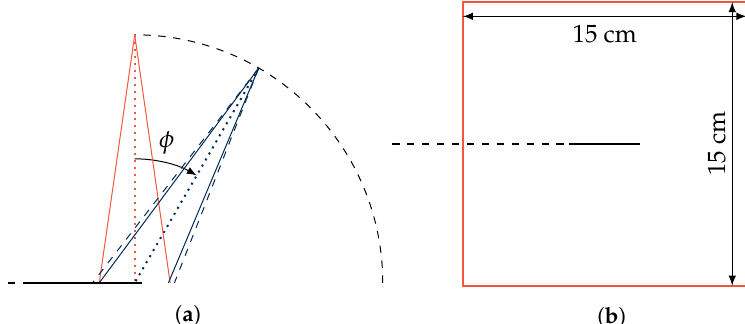
Figure 1. Schematic view of the beam tilting procedure. ( a ) View from the side, where φ is the tilting angle of the beam, and the sample with the transport fiber is marked by the horizontal black line ending in a dashed line. ( b ) View from the top, with the sample laying in the center of the beam window marked in orange, and the transport fiber directed to the left of the figure along the black dashed line. The beam tilting direction is towards the right.